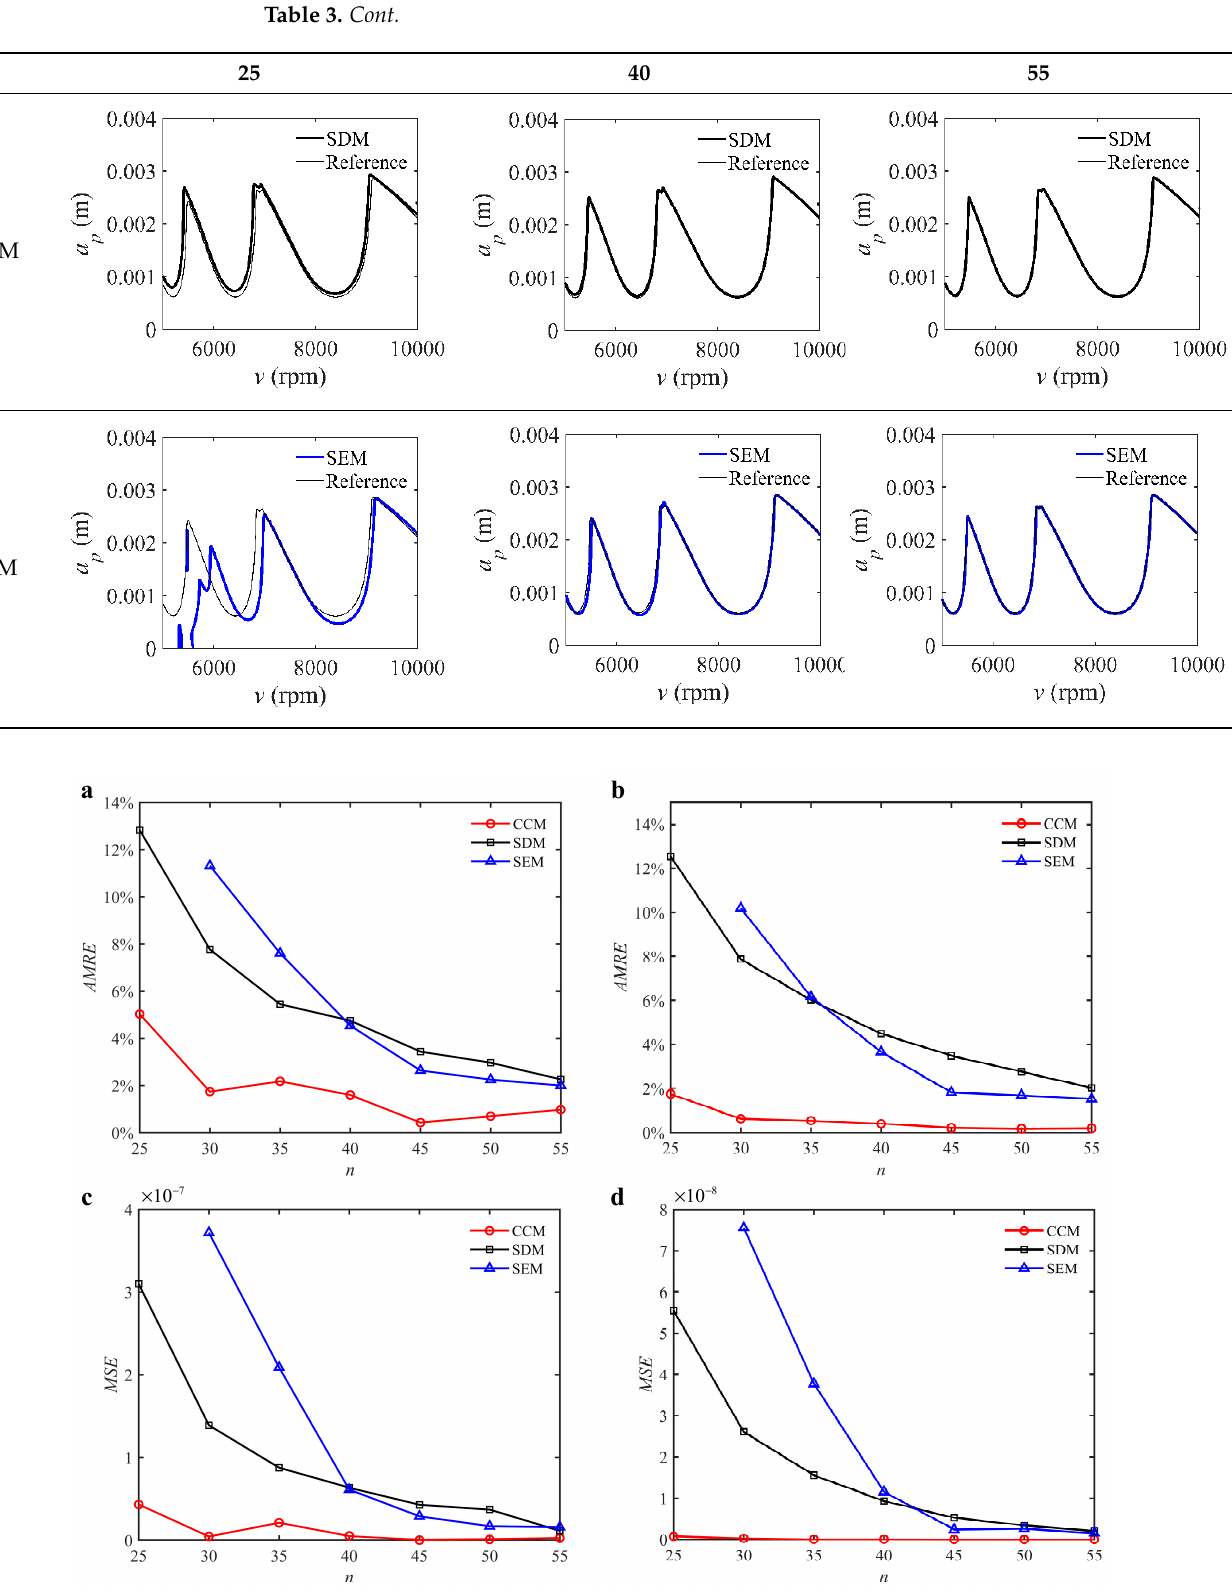
Figure 5. AMRE and MSE of the CCM, SDM, and SEM. ( a ) AMRE when a / D = 0.05; ( b ) AMRE when a / D = 0.5; ( c ) MSE when a / D = 0.05; ( d ) MSE when a / D = 0.5.